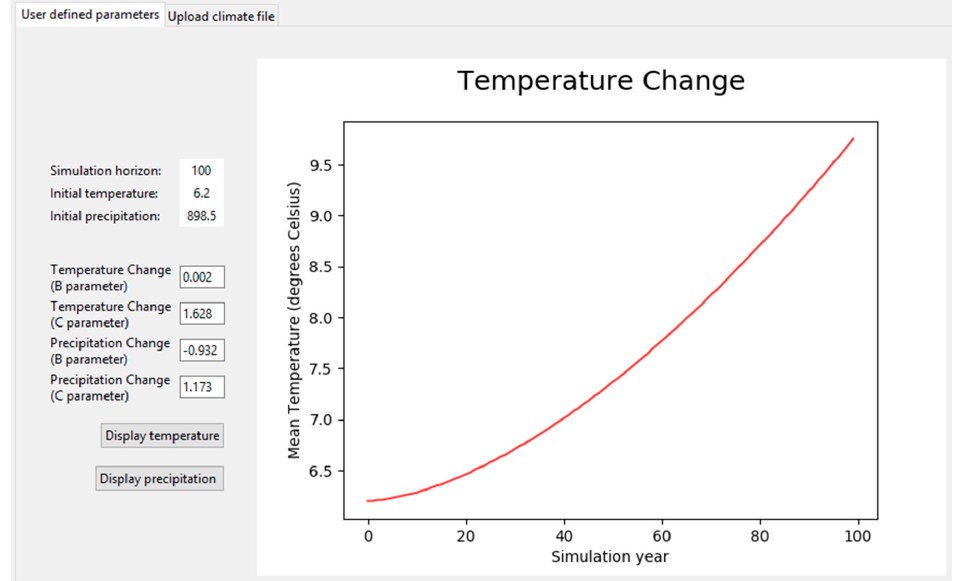
2 Figure 5. Climate change UI (user-defined parameters tab). Parameters B and C can be defined by the user in the left panel, and the climate change trend can be visualized in form of a graph, by triggering the display button.